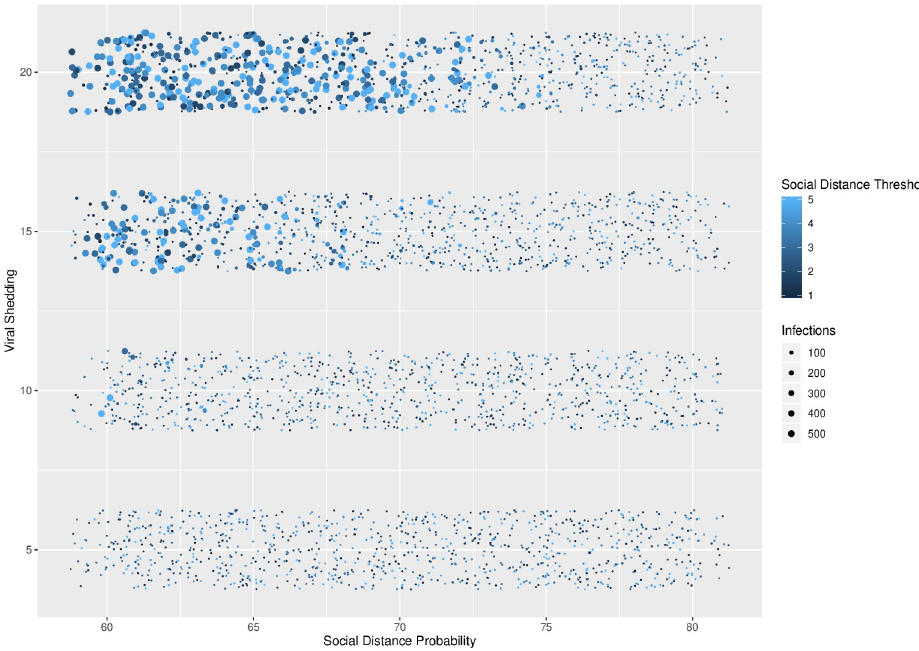
Fig 6. Total infections across social distance probability and viral shedding. Social distance probability vs. viral shedding, with social distance threshold and total number of infections indicated by color and size. Larger numbers of infections occur with low social distance probability and high viral shedding